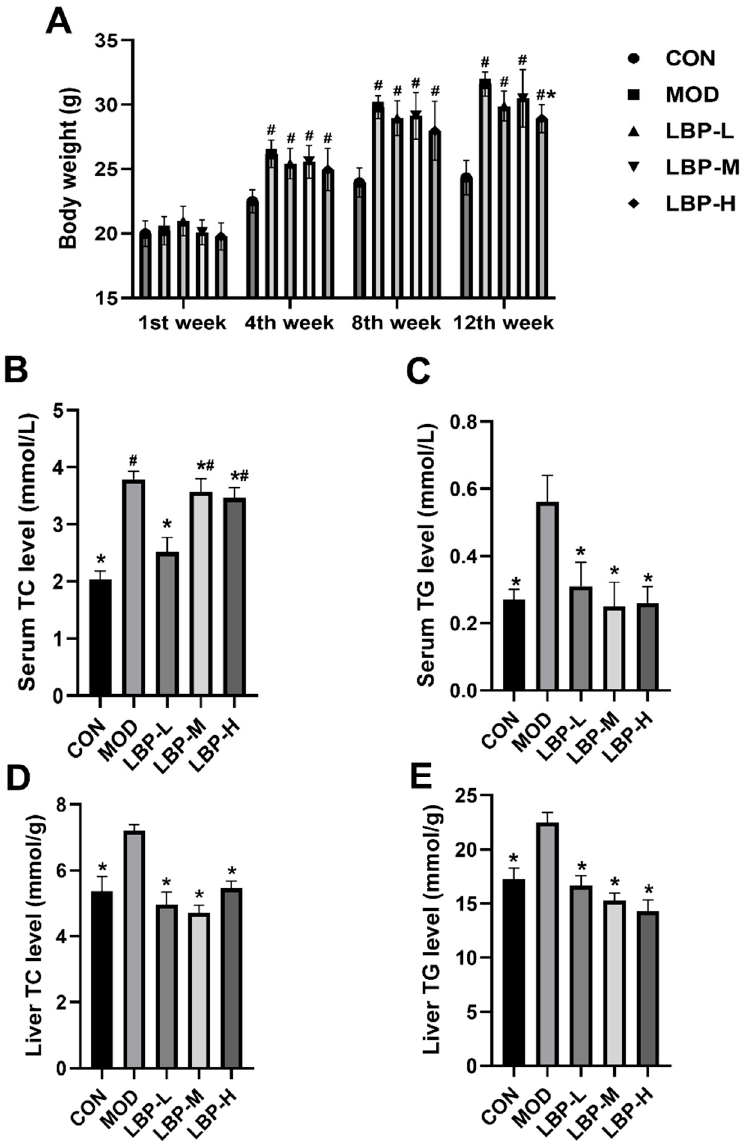
Figure 1. The outcomes of LBP feeding (50, 100, and 150 mg/kg) on high-fat diet induced mice on body weight ( A ), serum TC and TG ( B , C ), liver TC and TG ( D , E ). LBP, Lycium barbarum polysaccharide; TC, total cholesterol; TG, triglyceride. *, p < 0.05, compared with the model group (MOD); # , p < 0.05, compared with the control group (CON). Sample size for each group =